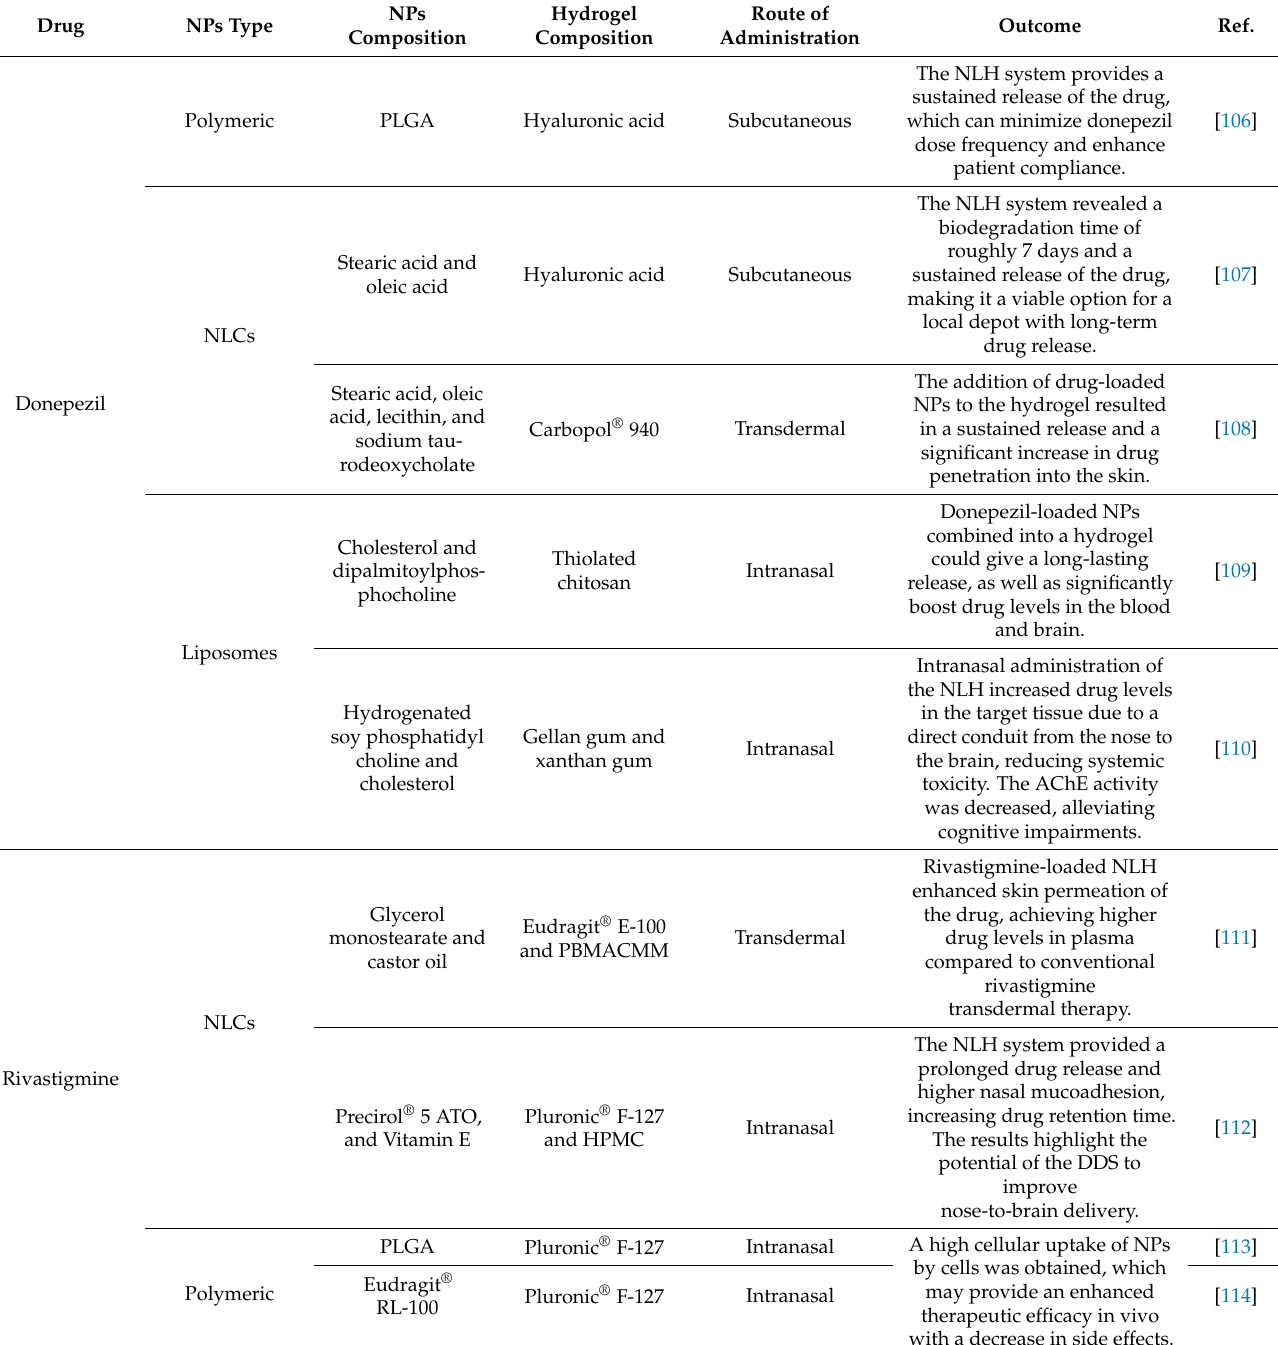
Table 4. The most recent applications of NLH systems as DDSs for delivering FDA-approved Alzheimer’s